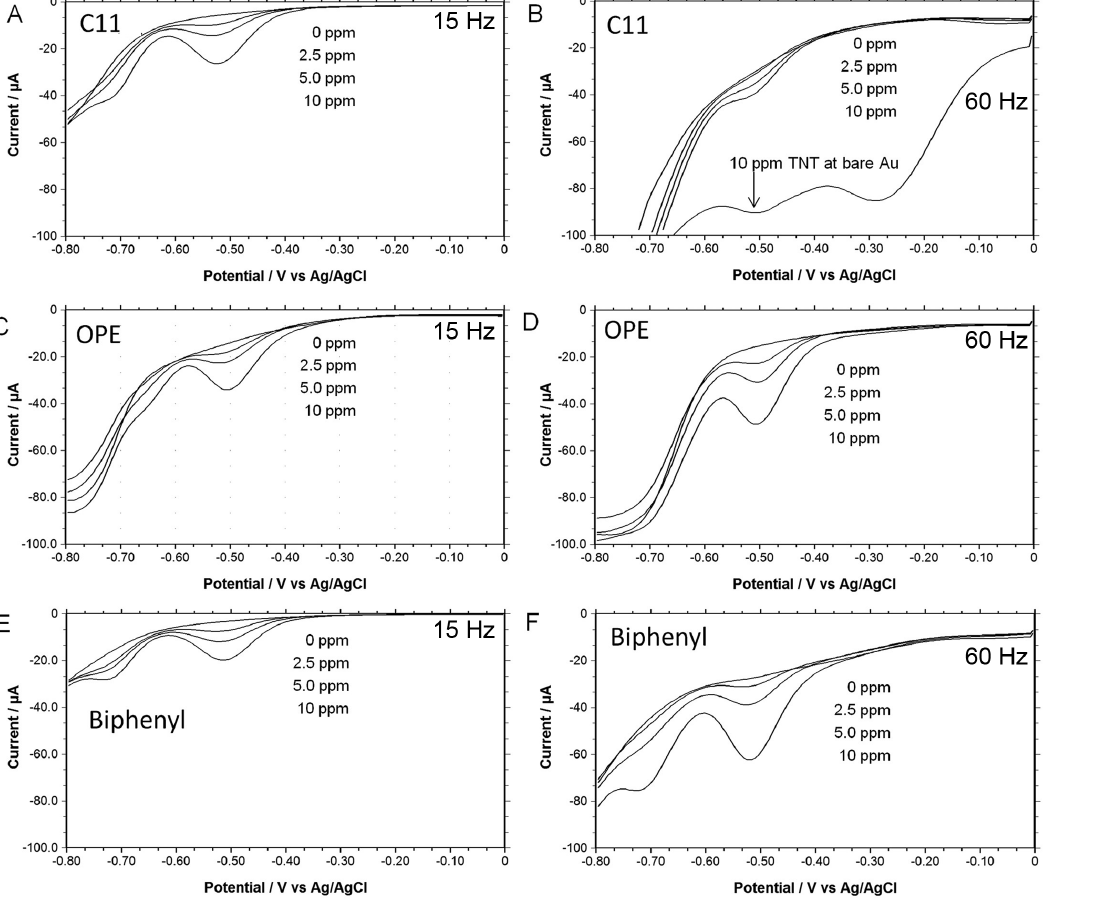
Fig. 2. Square wave voltammetry of several TNT concentrations in air-saturated 100 mM potassium phosphate, buffed at pH 8. A. The response of TNT at a C11 modified gold electrode measured at 15 Hz. B. The response of TNT at a C11 modified gold electrode measured at 60 Hz including a comparison to a bare gold electrode. C & D. The response of TNTat a OPE modified gold electrode measured at 15 Hz and at 60 Hz, respectively. E & F. The response of TNT at a Biphenyl modified gold electrode measured at 15 Hz and at 60 Hz,